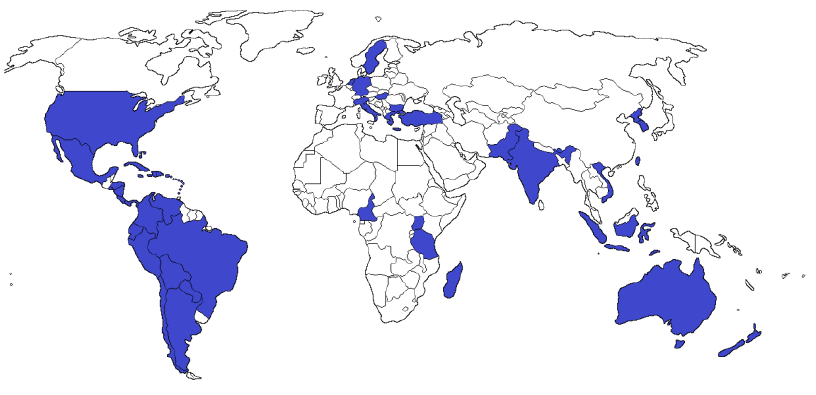
Figure 2. Global distribution map of Brugmansia suaveolens .